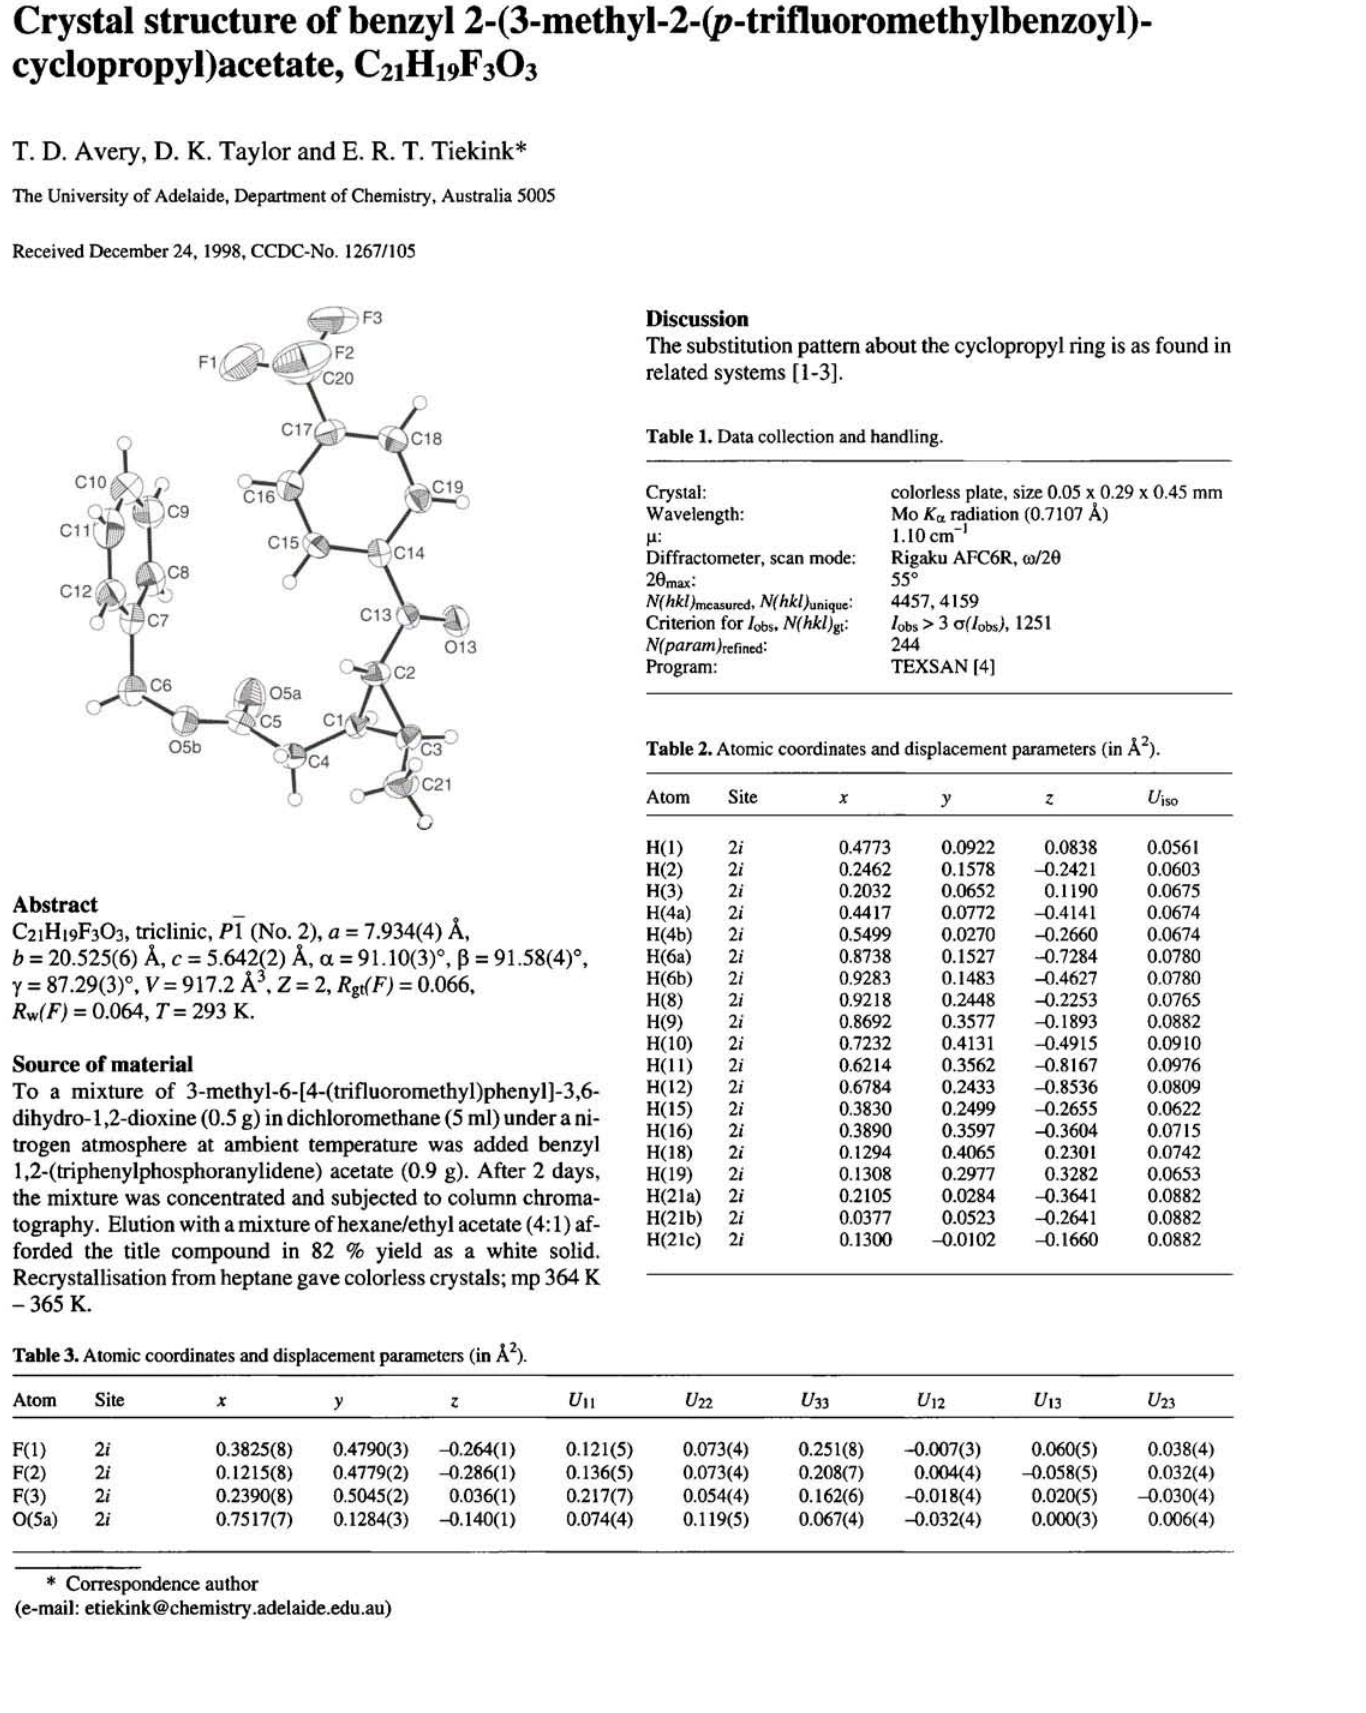
Table 1. Data collection and handling. Crystal: